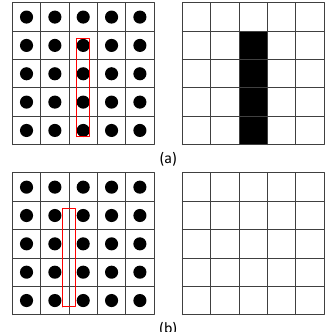
Figure 4. The flickering